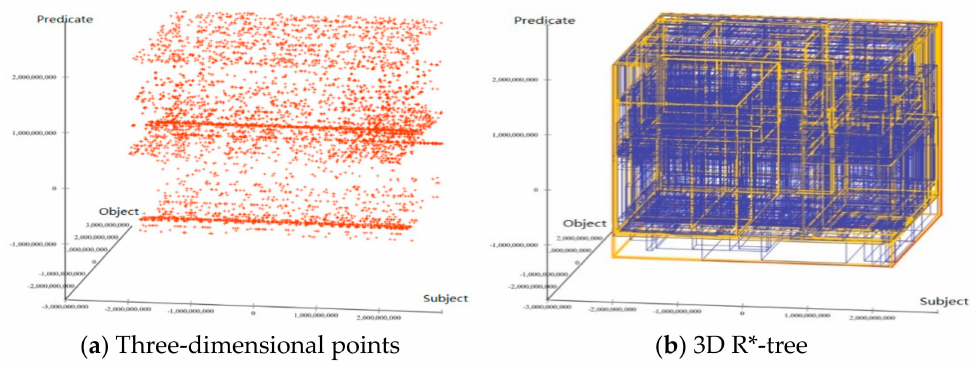
Figure 9. Three-dimensional points in the 3D